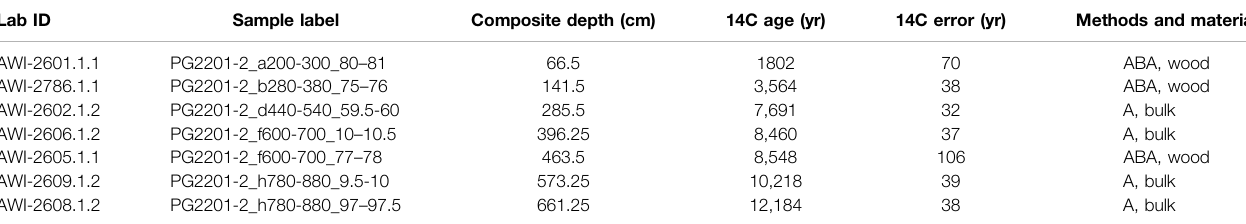
TABLE 1 | Radiocarbon ( 14 C) dated samples from Lake Malaya Chabyda sediment